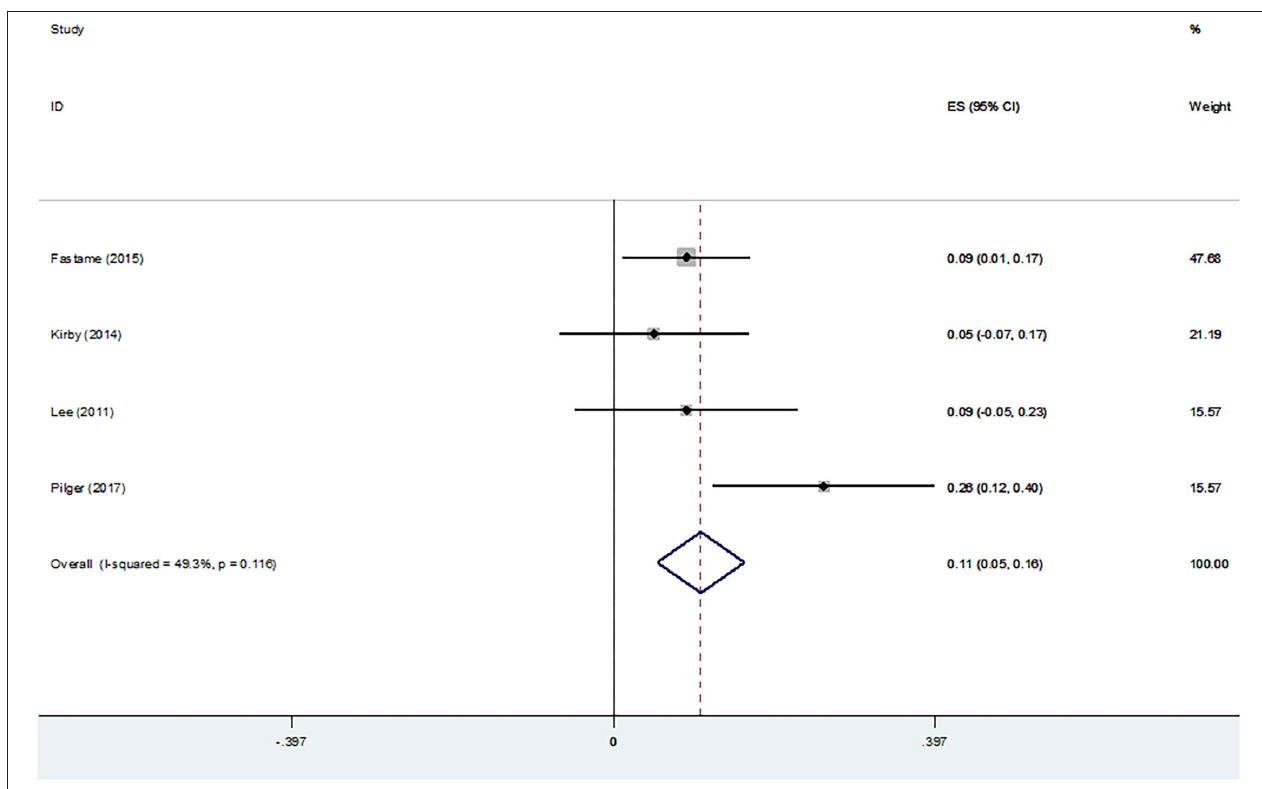
FIGURE 8 | Z-scores for psychological